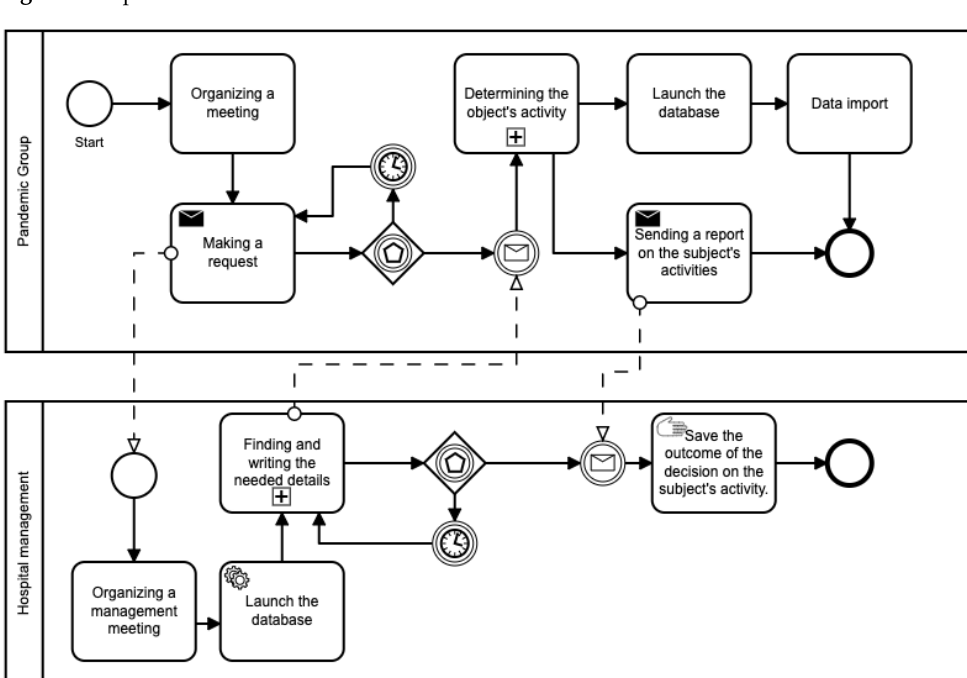
Figure 6. Object activity